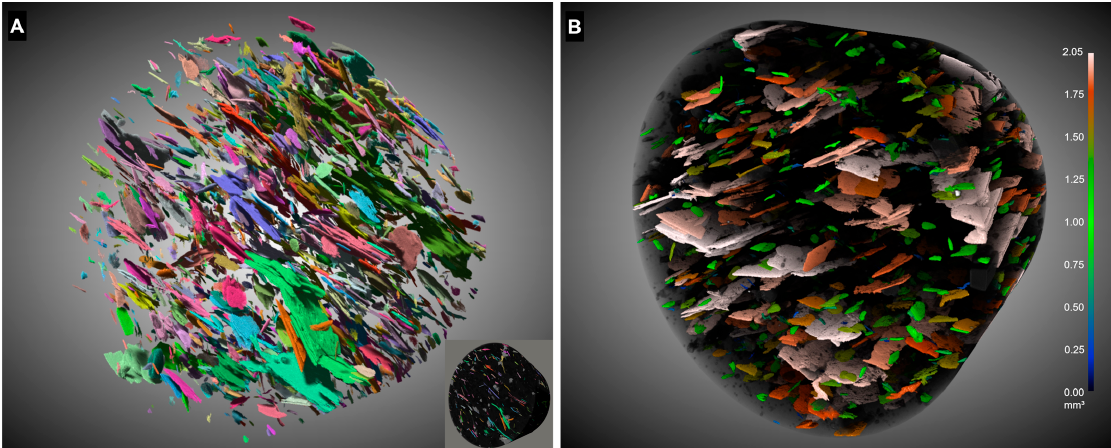
Figure 6. Three-dimensional CT images of the cylindrical subvolume after segmentation: ( A ) colour- coded graphite particles and ( B ) volumetric distribution of the graphite flakes. The gangue minerals comprising the ore matrix are semitransparent. The cylinder has a diameter of 10.53 mm and a thick- ness of 8.21 mm. To assess the quality of the sample based on the grain size distribution, the equivalent spherical diameter was calculated using the volume of each particle (Equation (1)).